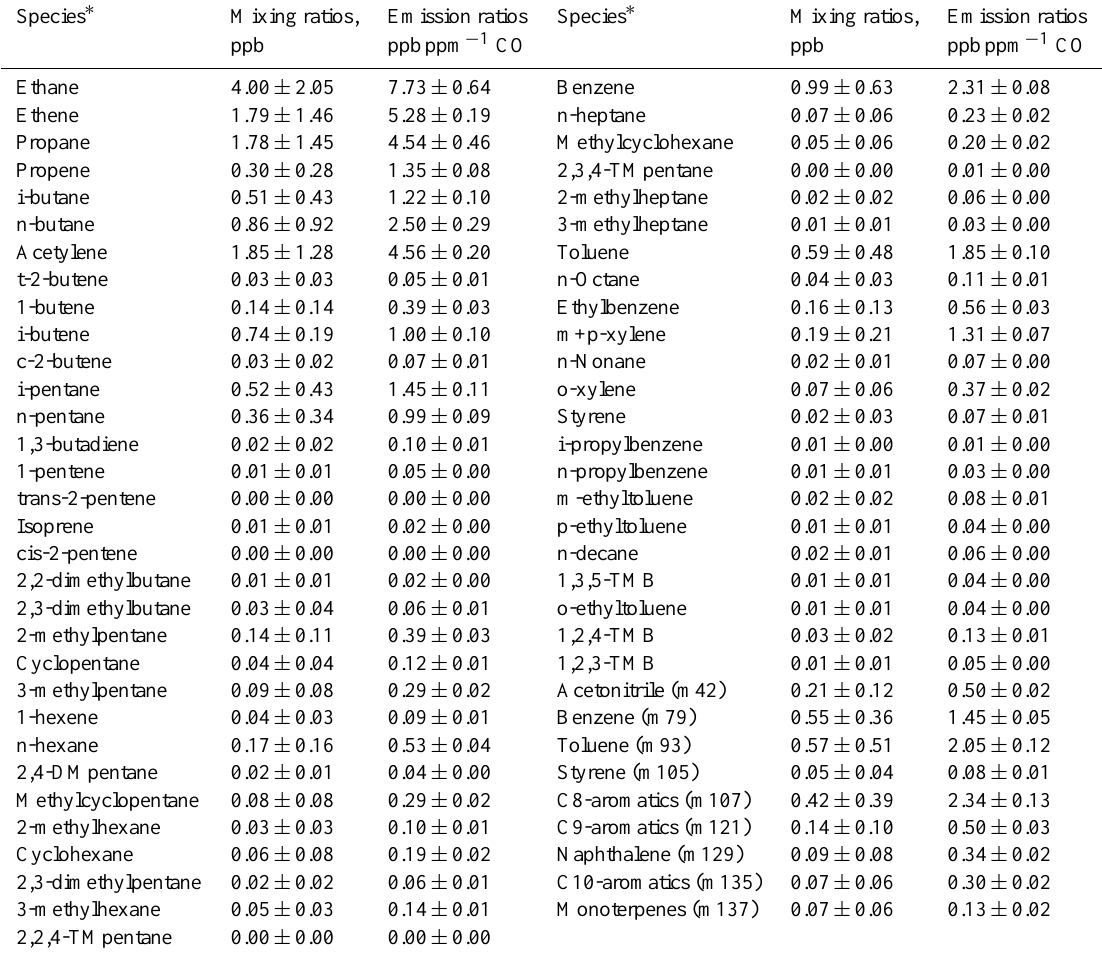
Table 1. Mixing ratios and derived emission ratios of various NMHCs to CO during the period 2–25 April 2011 at Changdao (aver- age ± standard